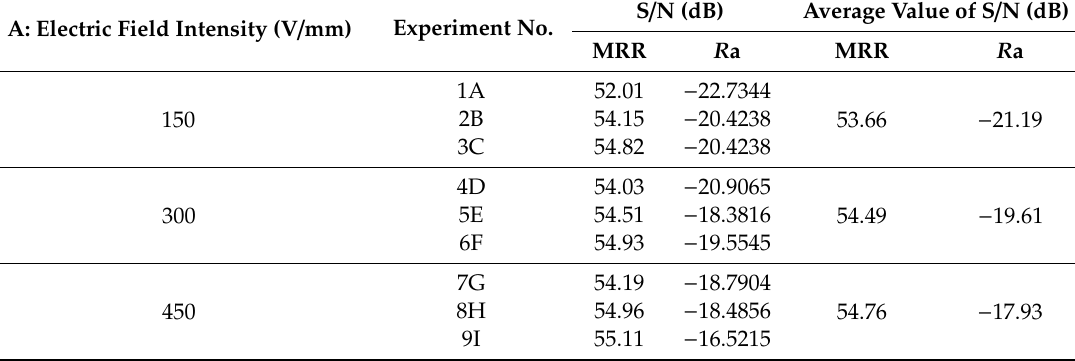
Table 3. Average value of S / N of electric field